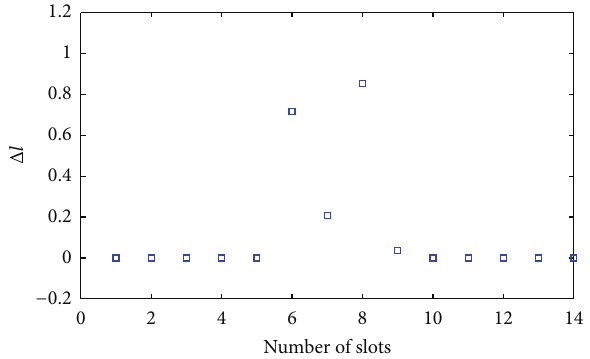
Figure 4: The difference between exact and estimated excitations (simulations) with failures at positions 𝑛 = 6 and 𝑛 = 8 : 𝑆 = 2 , 𝑀 = 11 , and MSE = 20